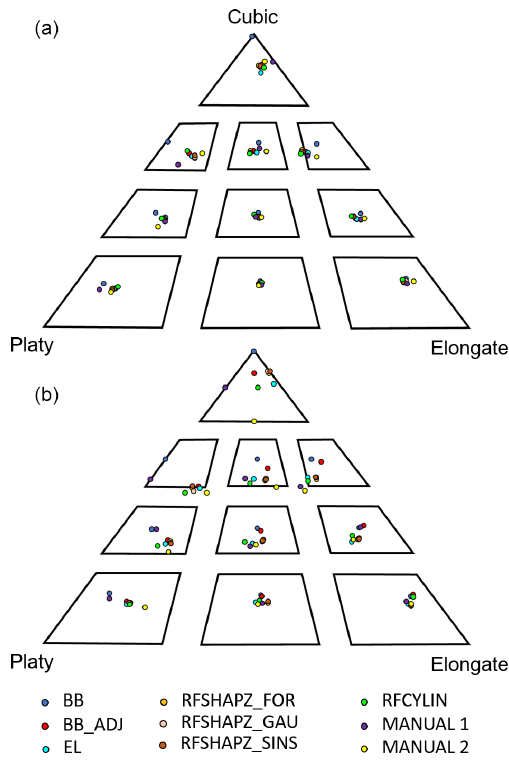
Figure 9. Sneed and Folk ternary diagrams separated to highlight shape classification results. (a) The results of each of the nine fits for each of the rounded synthetic blocks. (b) The results of each of the fits for the angular synthetic blocks. BB: